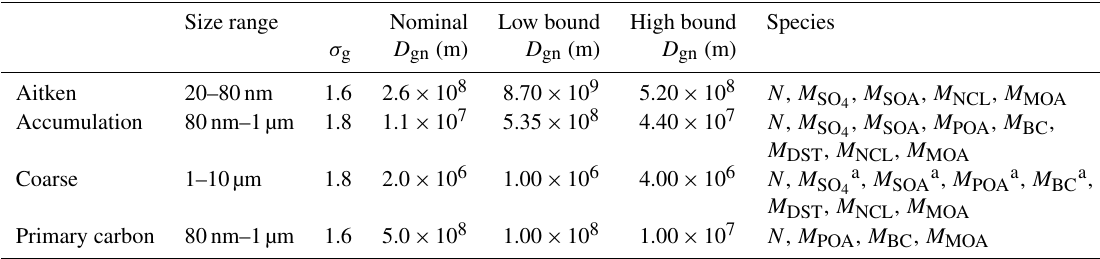
Table 2. MAM4 modes and their size parameters and tracers carried, including number ( N ) and species mass M species